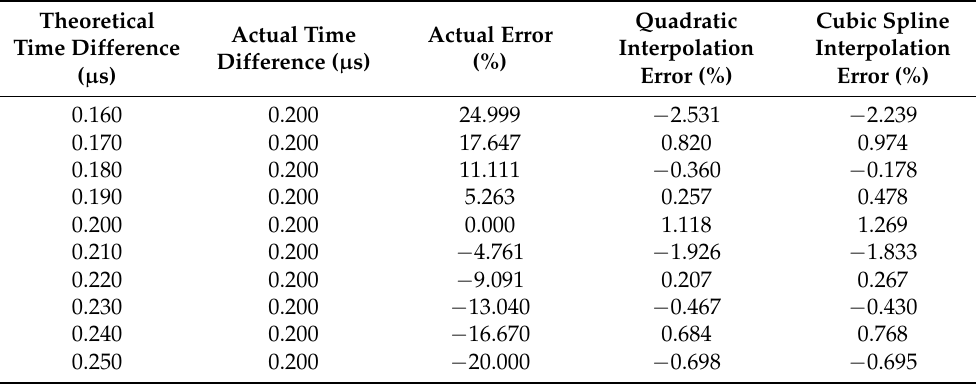
Table 1. Comparison of different interpolation fitting errors.